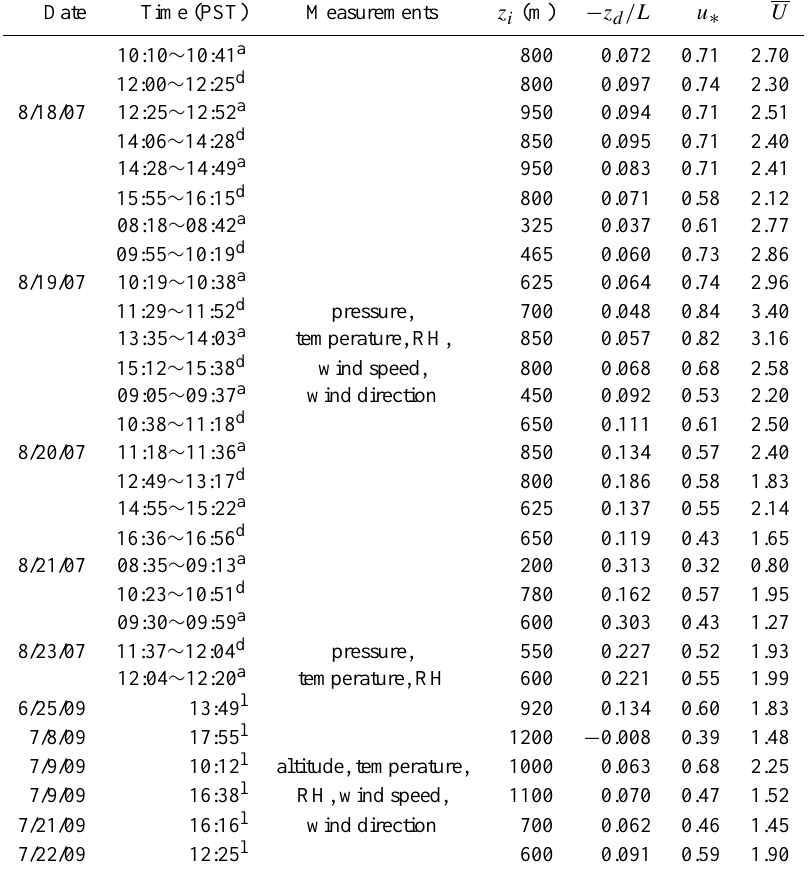
Table 1. Time of tether sonde flight, measurements conducted during flights, observed z i , − z d /L , u ∗ , and U obtained from the tower at